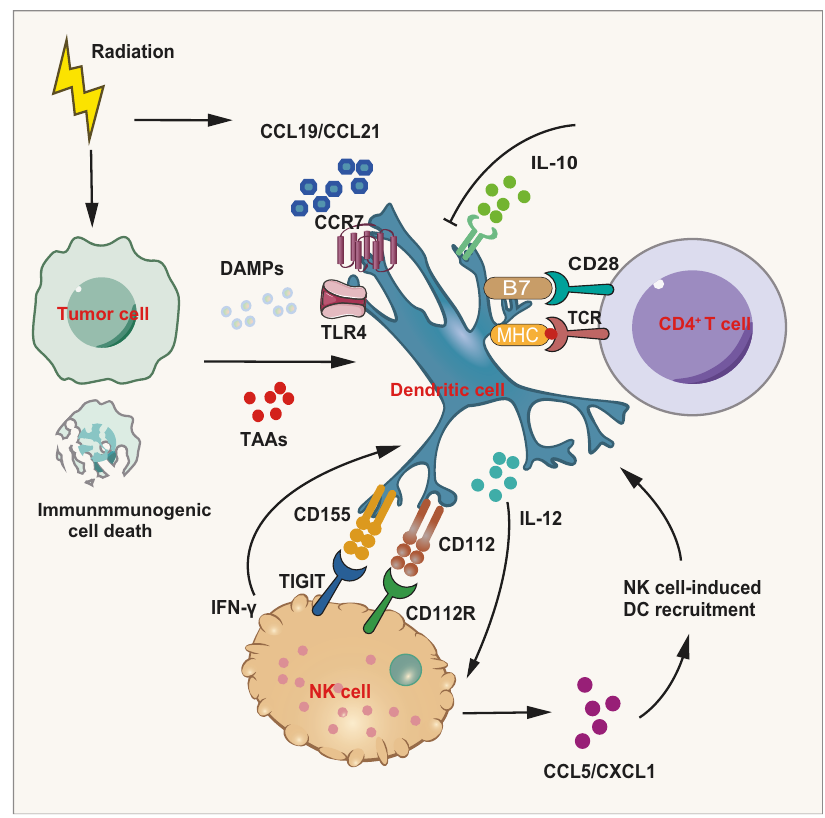
Fig. 7 Immunomodulatory effect of radiation on DCs. Radiation on DCs signi fi cantly increases the expression of chemokines CCL19 and CCL21 which then bind to CCR7 and mediate migration of DCs. In addition, immunogenic cell death caused by radiation may release large amounts of antigens and DAMPs including HMGB1, ATP, calreticulin, heat shock proteins, and other cellular factors which bind speci fi c pattern-recognition receptors on the dendritic cell, including Toll-like receptors, RIG1-like receptors, and NOD-like receptors. And radiation also results in the release of TAAs which promotes DCs activation, migration, and proliferation of T cells. Parts of this fi gure were drawn with aid of Servier Medical Art (http://www.servier.com), licensed under a Creative Commons Attribution 3.0 Unported